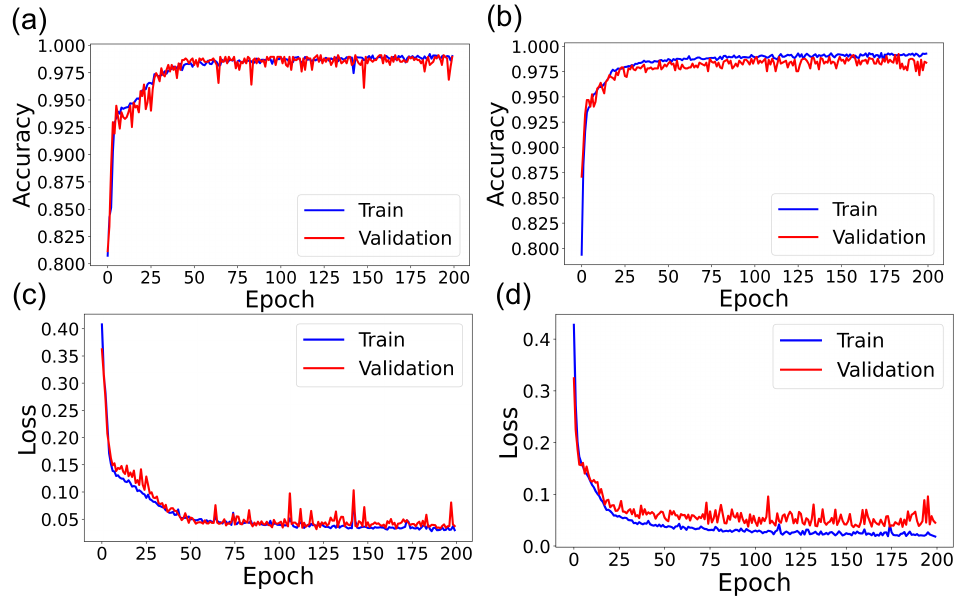
Figure 8. Accuracy and loss curves for SF in tubes with Lithium heparin. ANN with 2 hidden layers and 200 epochs. ( a ) Accuracy for unbalanced data. ( b ) Accuracy for balanced data. ( c ) Loss for unbalanced data. ( d ) Loss for balanced